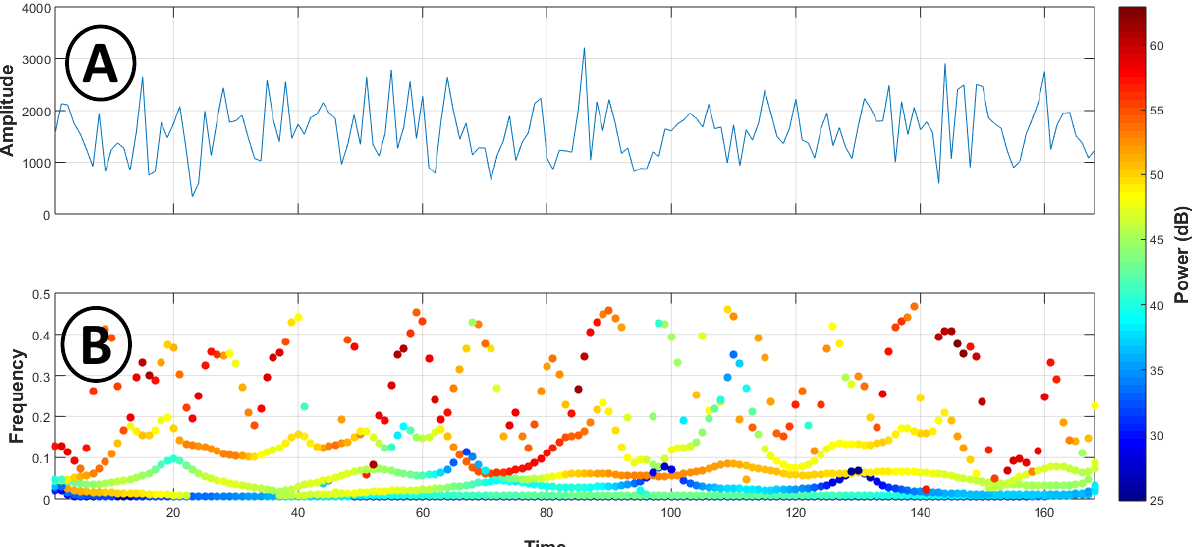
Figure 3. Hilbert transform of the signal decomposed using EMD; A) The synthetic time series by summing IMFs, and B) signal power plotted in time-frequency.